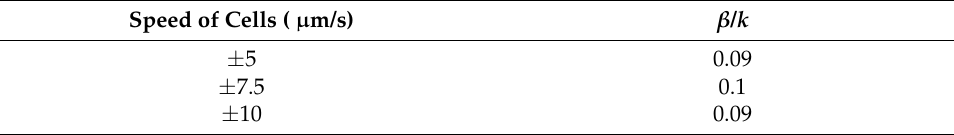
Table 1. Values of β /k in yeast cells